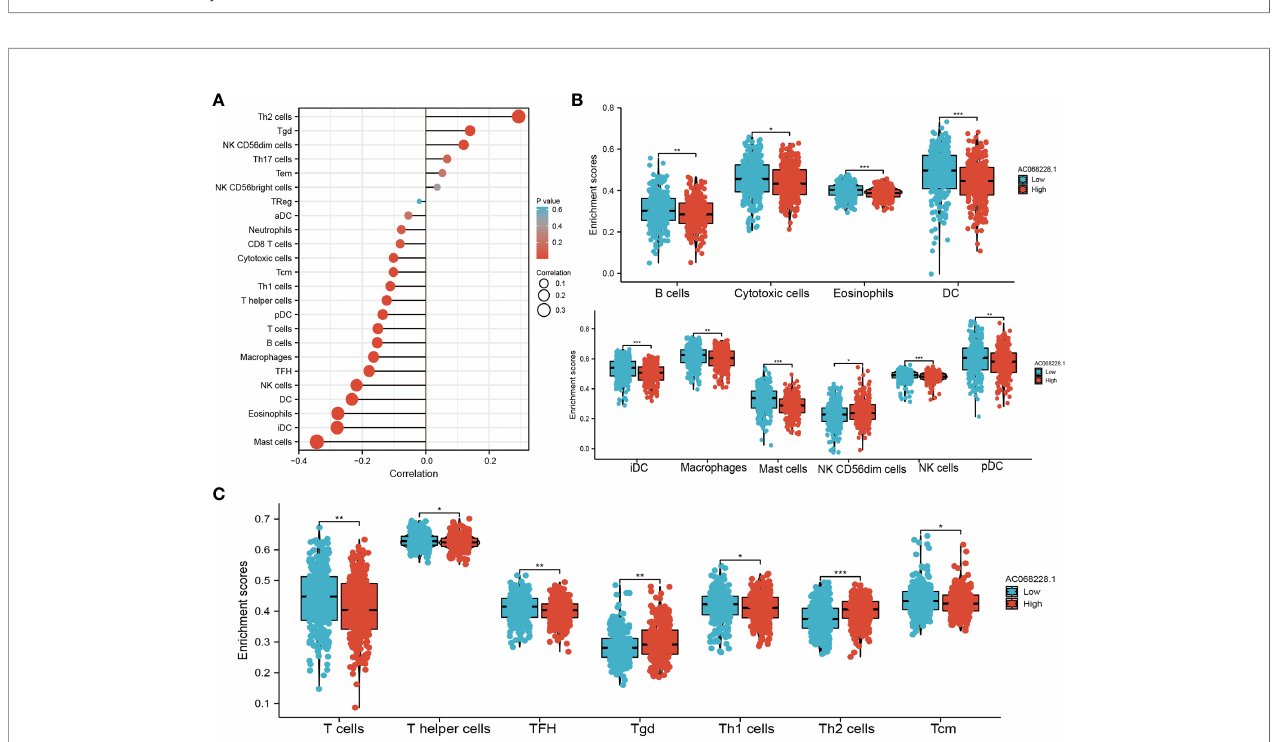
FIGURE 8 | Correlation analysis of AC068228.1 expression and in fi ltration levels of immune cells in LUAD tissues. (A) Correlation between the relative abundances of 24 immune cells and lncRNA AC068228.1 expression level. (B, C) Box plots of the correlations between AC068228.1 or molecular model expression and in fi ltration levels of immune cells. *p < 0.05, **p < 0.01, ***p <